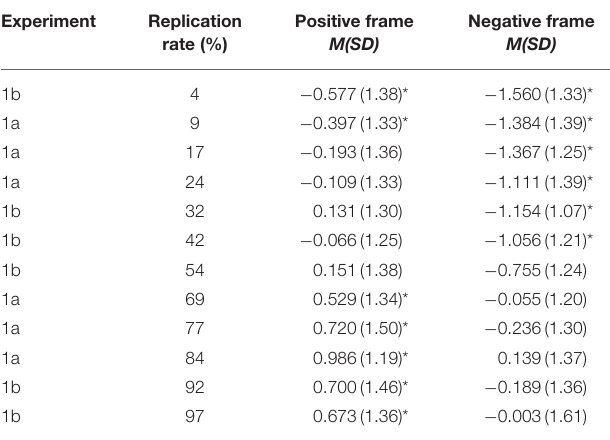
TABLE 1 | Mean and standard deviation of difference scores for Experiments 1a and 1b. Experiment